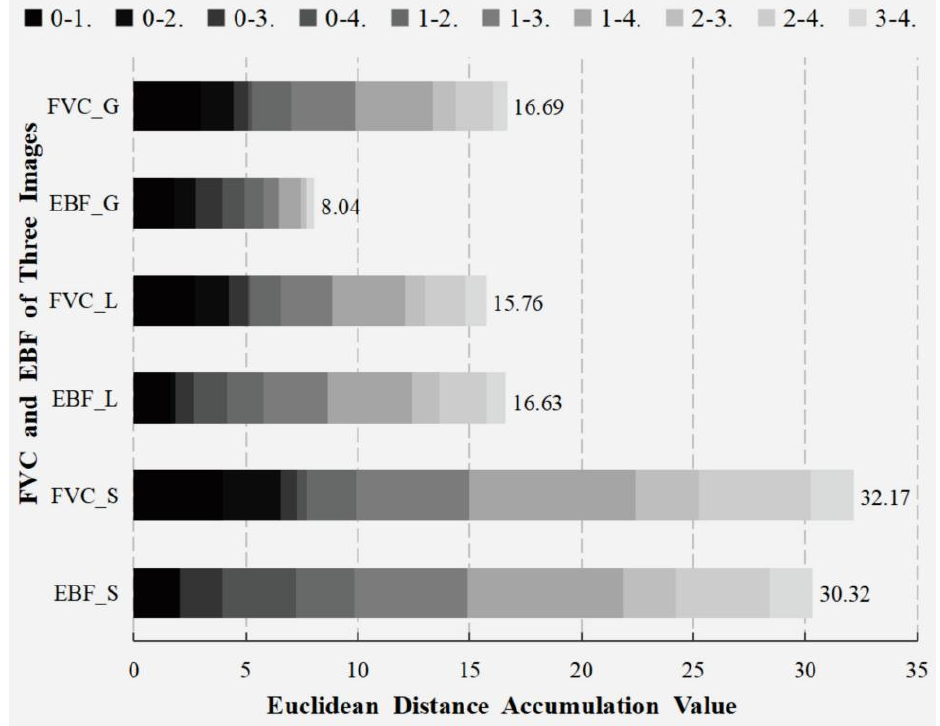
Figure 4. Euclidean distance accumulation histogram of five indices for classification of rocky desertification (“S”, “L”, and “G” represent three types of images of Sentinel-2B, Landsat-8, and Gaofen-6; 0, 1, 2, 3, and 4 represent no rocky desertification, potential level, mild level, moderate level, and severe level, respectively. For example, “3–4” is the Euclidean distance between moderate and severe rocky desertification.).